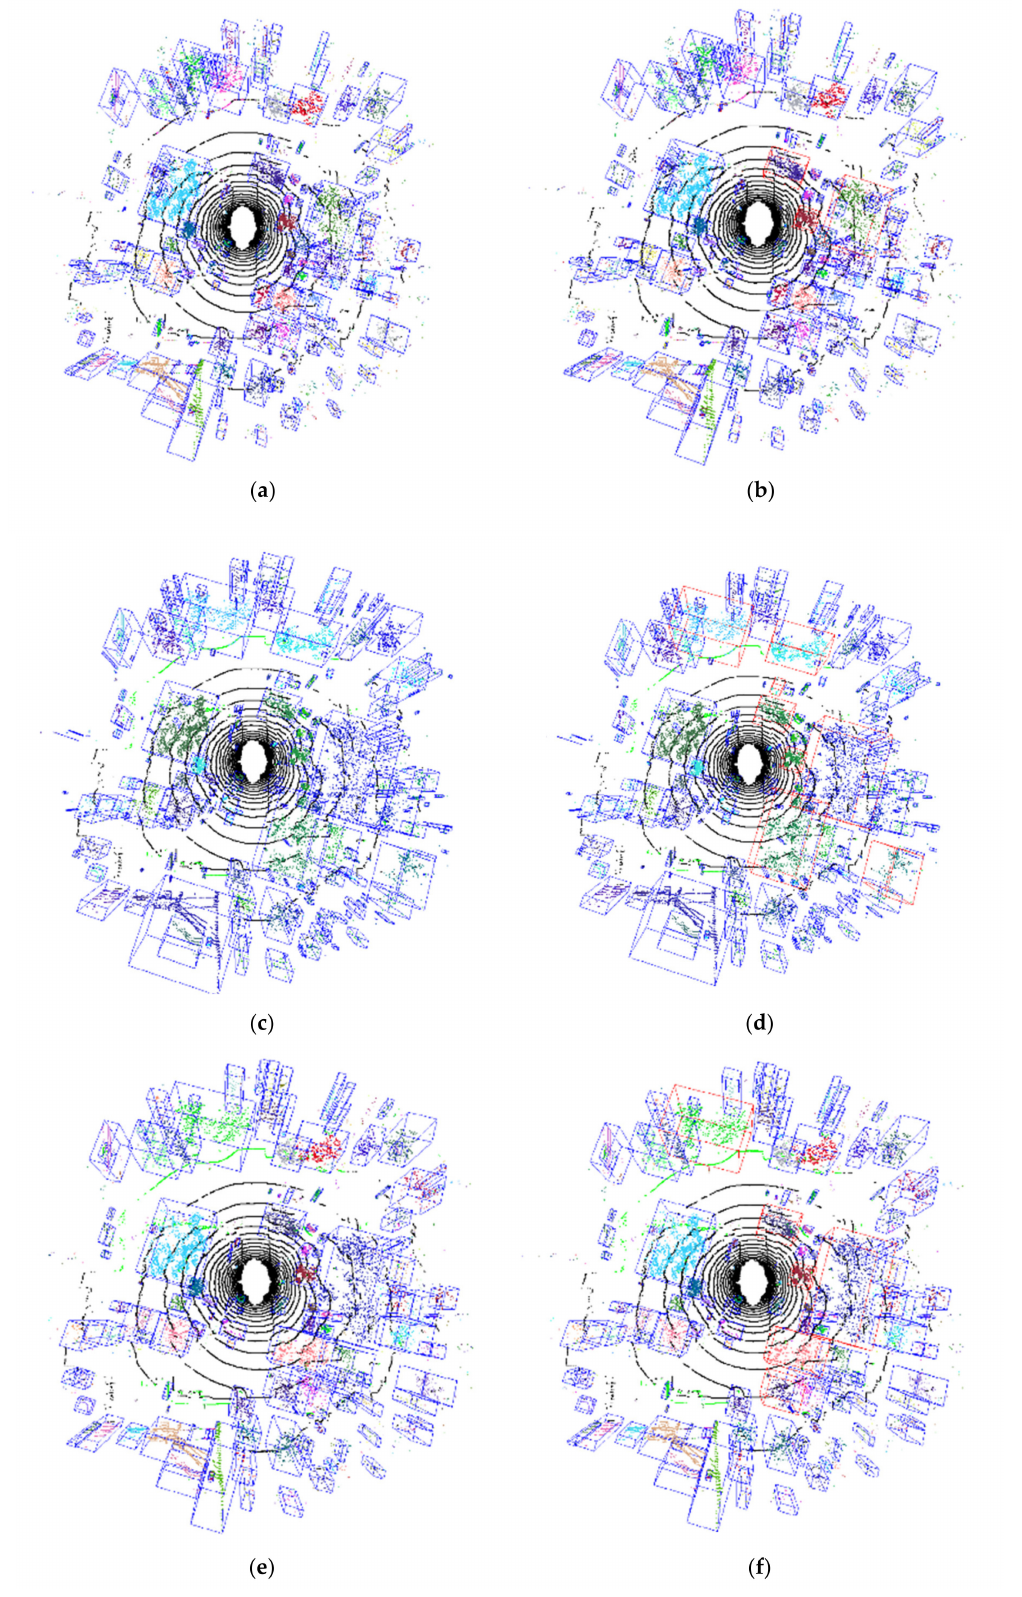
Figure 10. Obstacle clustering results in x – z horizontal plane obtained using three algorithms: ( a ) ER-CCL; ( c ) connected component analysis; ( e ) clustering in hash table; ( b , d , f ) Manually marked error clustering